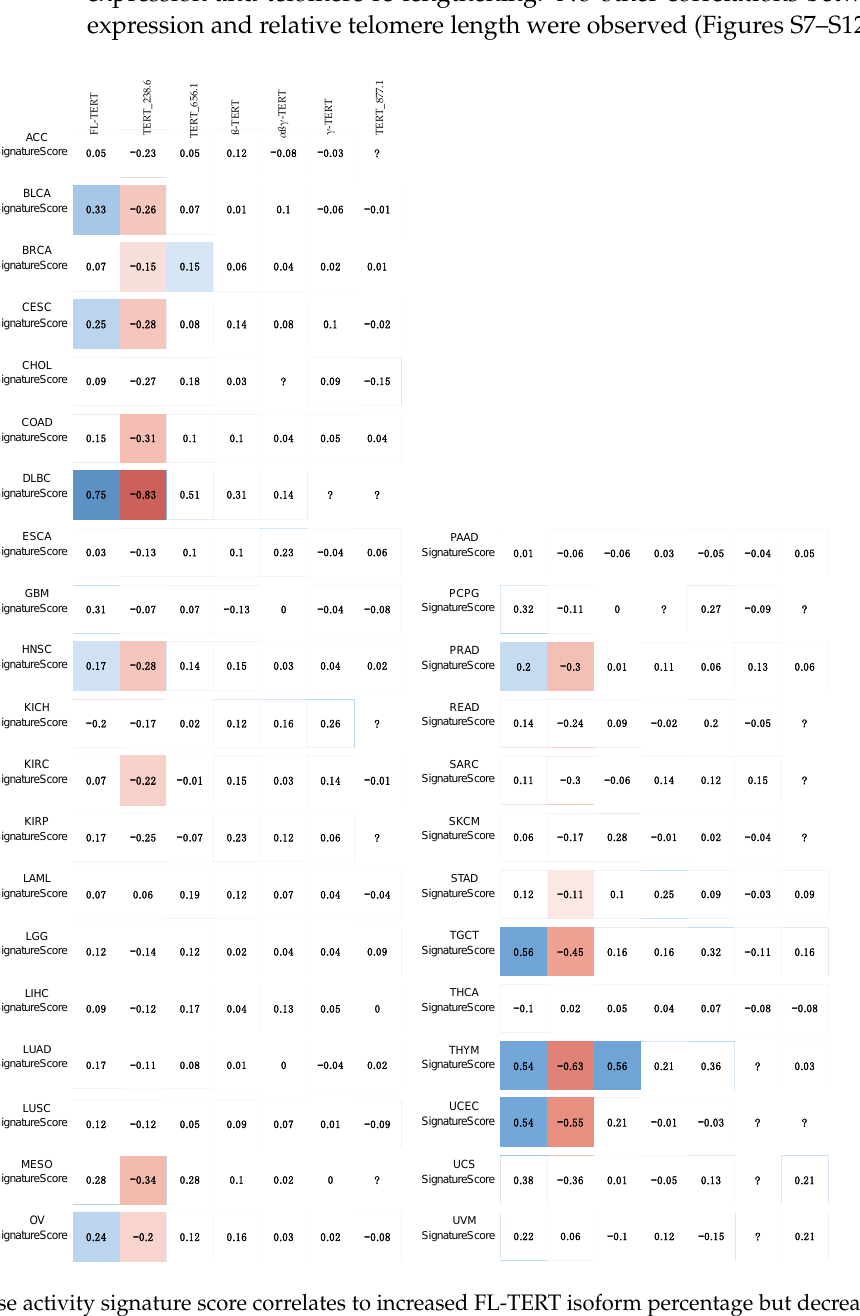
Figure 4. Telomerase activity signature score correlates to increased FL-TERT isoform percentage but decreased TERT_238.6 isoform percentage. FL-TERT isoform percentage (significant in 9/33 cancer types) had all positive correlations. TERT_238.6 isoform percentage had significant negative correlations in 14/33 cancer types and TERT_656.1 had significant positive correlations in 2/33 cancer types. β -TERT, αβγ -TERT, and γ -TERT isoform percentage had no significant correlations to signature score expression. Spearman correlations were computed and significance determined using a Bonferroni corrected p -value of <0.000216 (0.05/231 comparisons). Correlations were highlighted with colour only if significant, blue indicating a significant positive correlation, and red indicating a significant negative correlation. Spearman’s coefficients are displayed, and colour intensity also indicates the strength of correlation. Question marks (“?”) indicate no correlation could be computed between signature score and the respective TERT